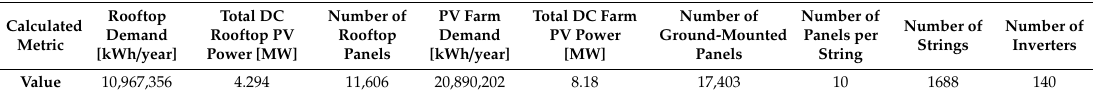
Table 3. System sizing